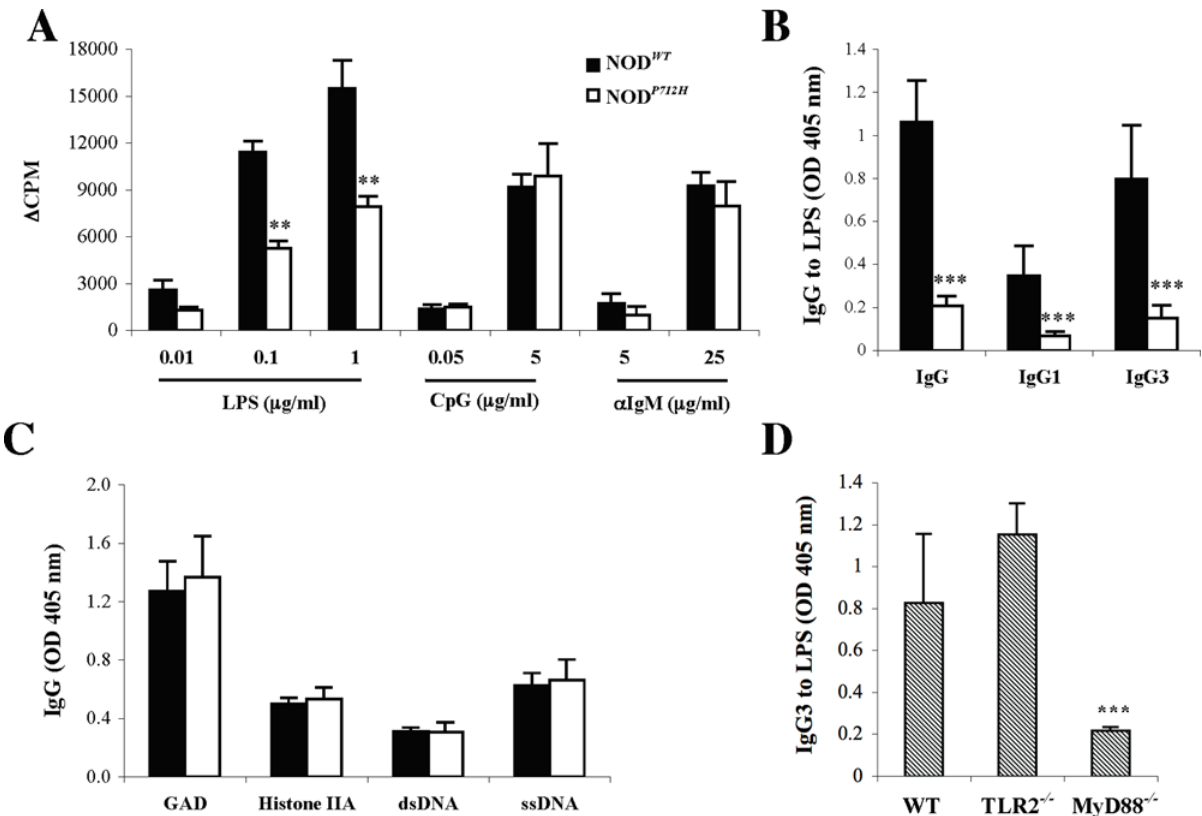
Figure 2. Natural Anti-LPS IgG3 is generated via MyD88-dependant TLR4 signaling. A. Purified B cells from NOD P712H and NOD WT mice were activated in vitro with LPS, CpG or a IgM and the proliferative response was assayed. ** P , 0.01 when compared to NOD WT mice. B. Total IgG and IgG1 vs. IgG3 antibodies to LPS in NOD WT (n=13) and NOD P712H mice (n=7). *** P , 0.001 when compared to NOD WT mice. C. IgG antibodies to GAD, histone IIA, dsDNA and ssDNA in NOD WT (n=13) and NOD P712H mice (n=7). D. IgG3 antibodies to LPS in WT, TLR2 2 / 2 and MyD88 2 / 2 mice (n=4). *** P , 0.001 when compared to WT or TLR2 2 / 2 mice. Results represent mean ( 6 SD) of each group.